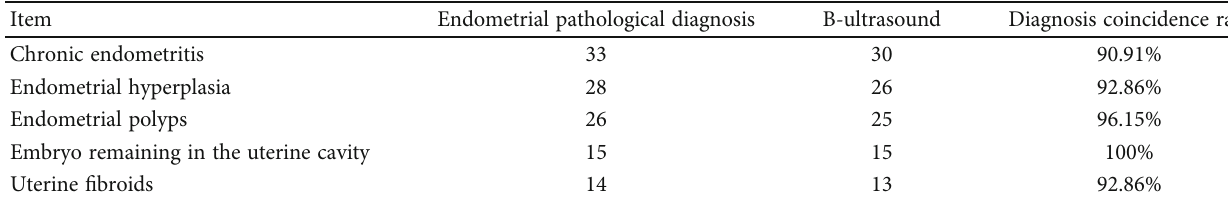
Table 5: B-Ultrasound diagnosis of